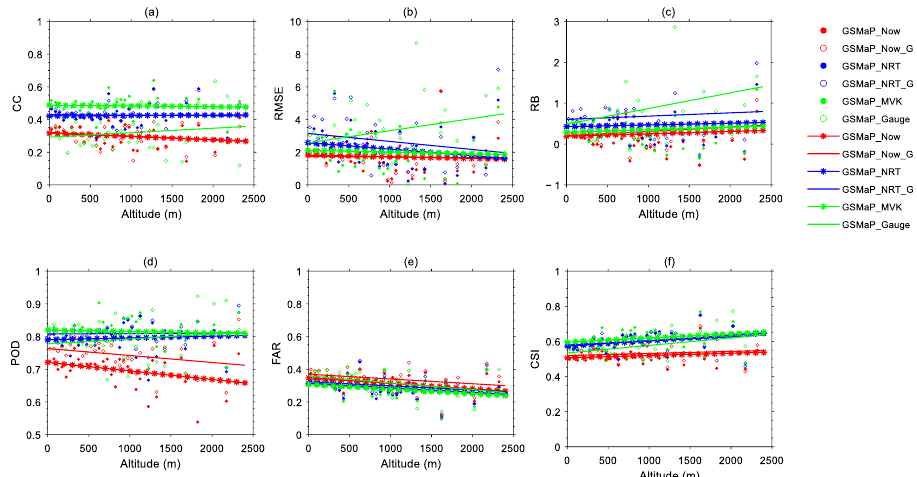
Figure 13. Linear fitting of daily CC ( a ), RMSE ( b ), RB ( c ), POD ( d ), FAR ( e ), and CSI ( f ) with altitude. Statistical parameters created in data intervals per 50 ASL.